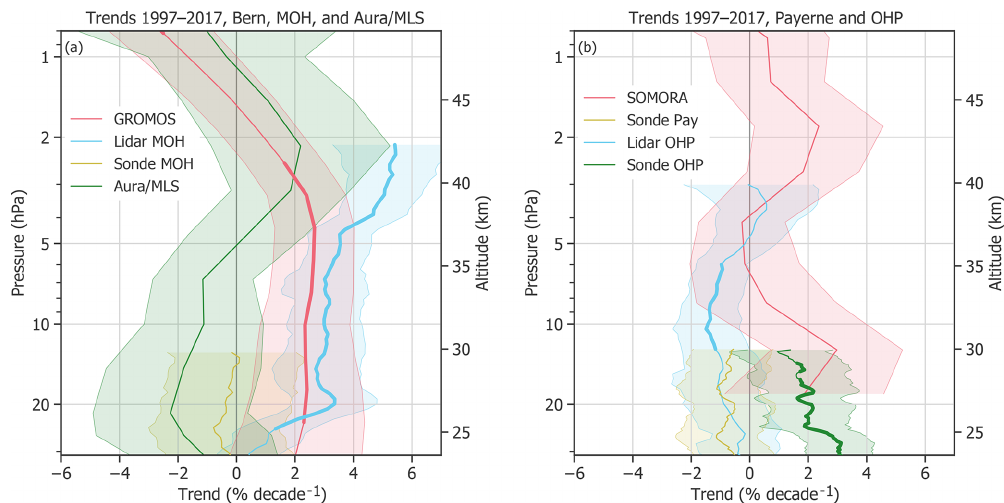
Figure 10. Ozone trends of different ground-based instruments in central Europe and Aura/MLS (over Bern, Switzerland). The 2 σ uncer- tainties are shown by shaded areas. Bold lines indicate trends that are significantly different from zero (at a 95% confidence interval). The trends at Bern and MOH as well as the Aura/MLS trend are shown in (a) , whereas (b) shows the trends from data sets at Payerne and